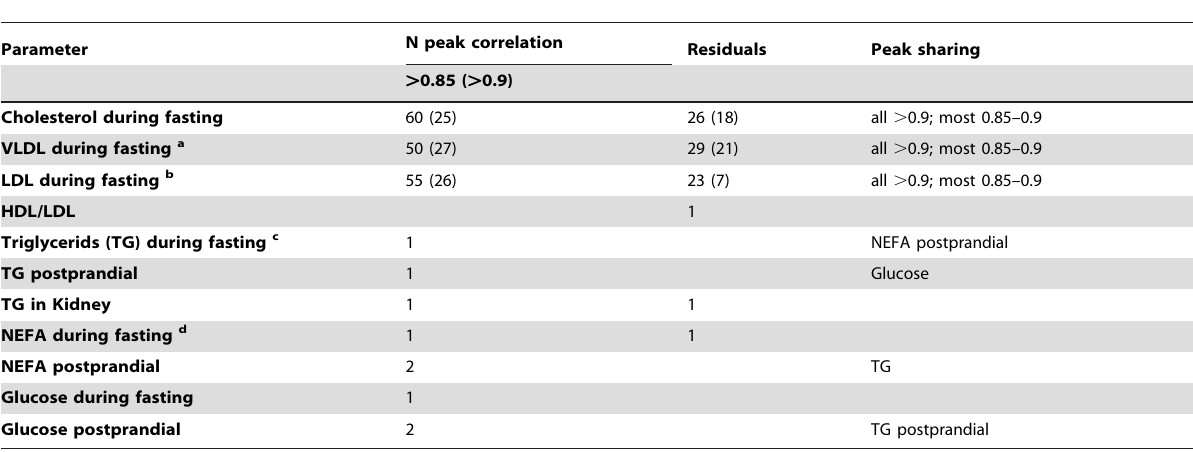
Table 4. Correlations between plasma proteome profiles and physiological parameters.